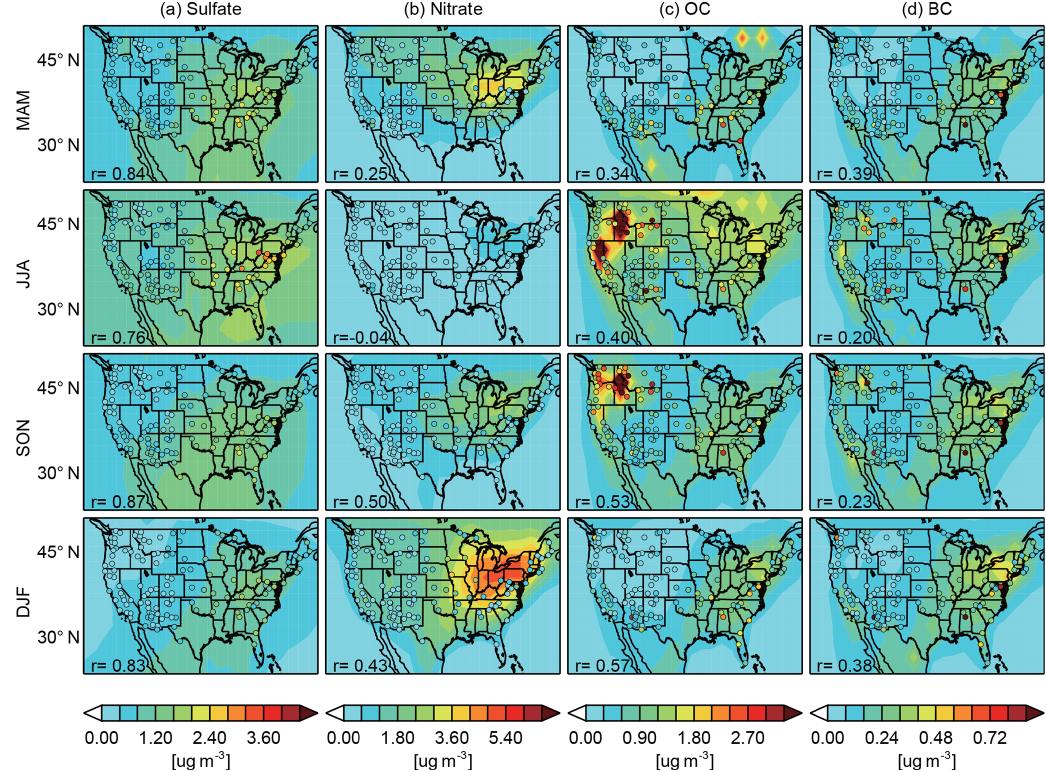
Figure 12. Spatial and seasonal distributions of simulated surface concentrations (contours) of (a) aerosol sulfate, (b) nitrate, (c) organic carbon, and (d) black carbon compared with observations from the United States IMPROVE network (circles) for 2012–2014. Correlation coefficients between observations and model results sampled at the site locations are shown